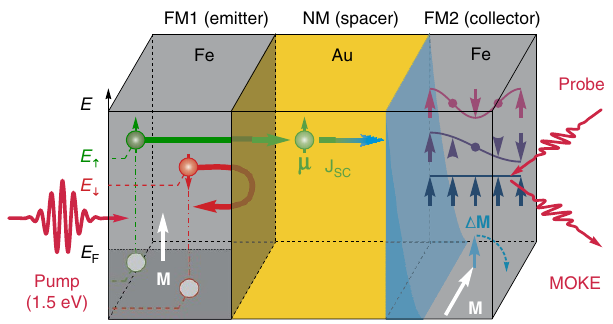
Figure 1 | Laser-induced excitation of spin dynamics via SC pulses. Laser pump pulse impinging on the first Fe layer (emitter) excites hot electrons at elevated energies E m , k . Because of the unequal transmittance of the Fe/Au interface for the majority (green) and minority (red) hot electrons 5 , the emission of hot electrons into Au is largely spin polarized. Having crossed the Au layer in a nearly ballistic regime, the electrons reach the second ferromagnetic (FM2) layer and transfer their spin to it. Owing to that, STT is exerted on the magnetization M C , which is driven out of the equilibrium and starts precessional dynamics. Due to the spatial confinement of the STT perturbation 22 (blue shaded area), spin waves with a broad spectrum of non- zero wavevectors k are excited and can be probed by the MOKE in the